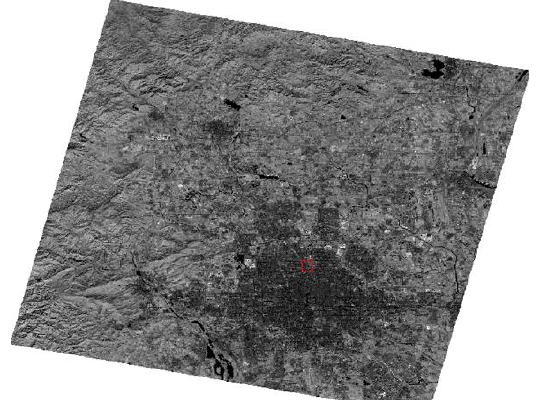
Figure 4 . Comparison of image size before and after clipping (the image after clipping is in the red box) 4.3.2